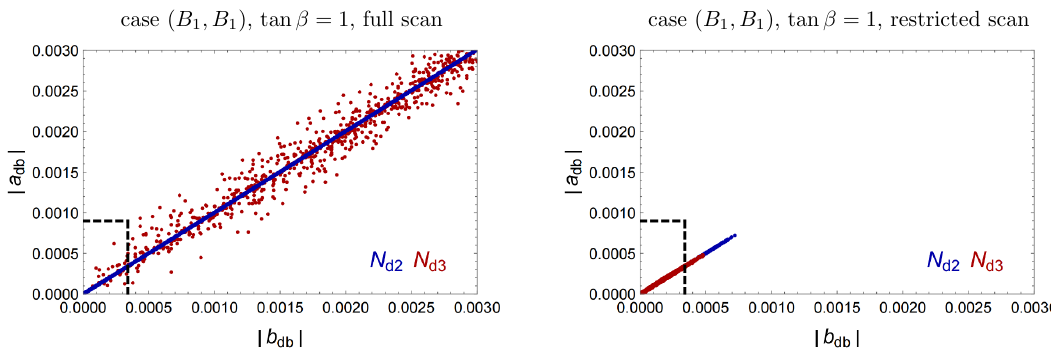
Figure 5 . The impact of B -meson oscillations. Shown are the values of | a db | , | b db | in a full scan (left) and a restricted scan with θ = π/ 100 (right). The dashed box shows the limits eq. max